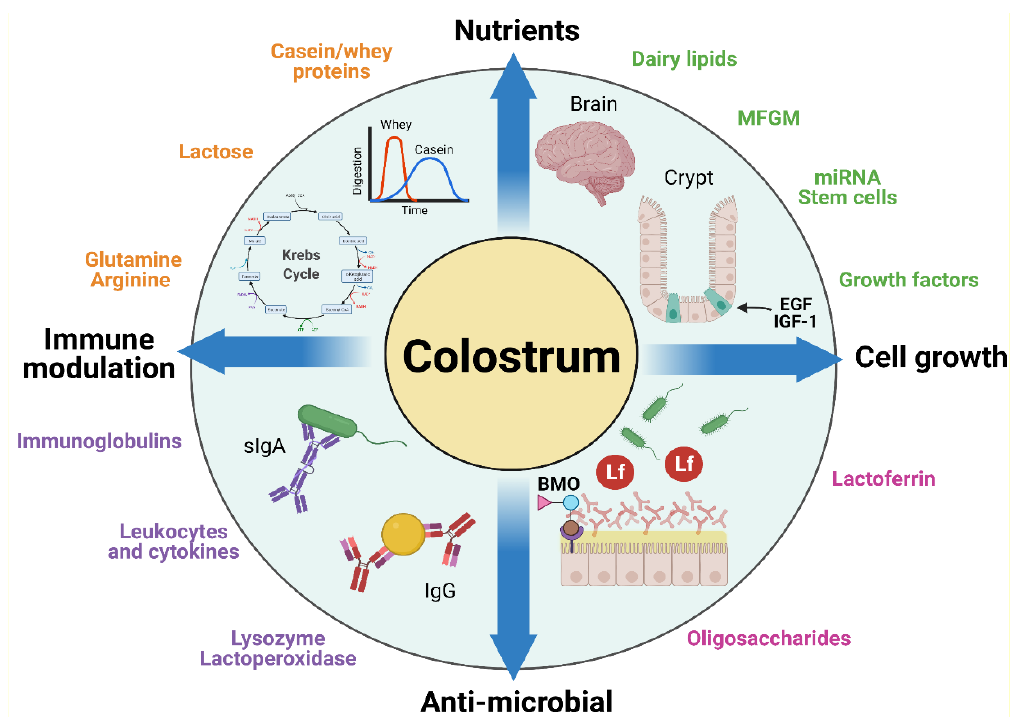
Figure 2. Nutritional and bioactive components present in bovine colostrum. The figure shows some of the key biological functions of bovine colostrum components related to their partially overlapping nutritional, immunomodulatory, antimicrobial, and cell-growth functions. (Created with BioRender.com; accessed on 7 June 2021).